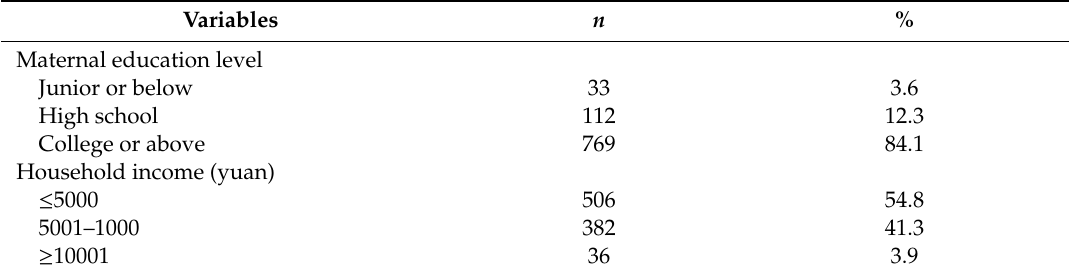
Table 1. Baseline socio-demographic characteristics and the follow-up weight retention of the